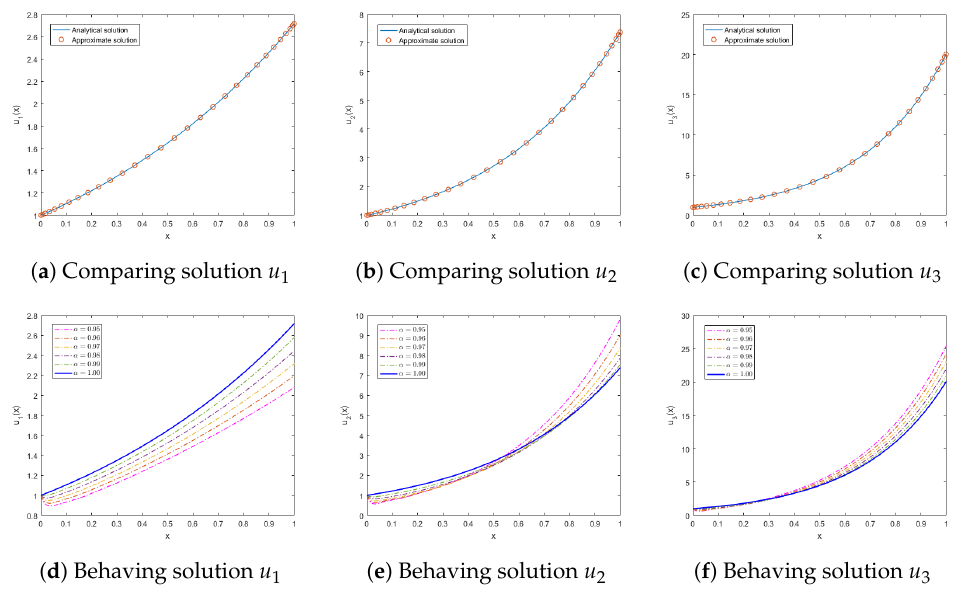
Figure 3. The behaviors of the approximate solutions in Example 3. The comparing graphs be- tween approximate and exact solutions as depicted in ( a – c ) and also the behaviors of the obtained solutions when the fractional order α → 1 are shown in ( d – f ), where α 1 = α 2 = α 3 : = α ∈